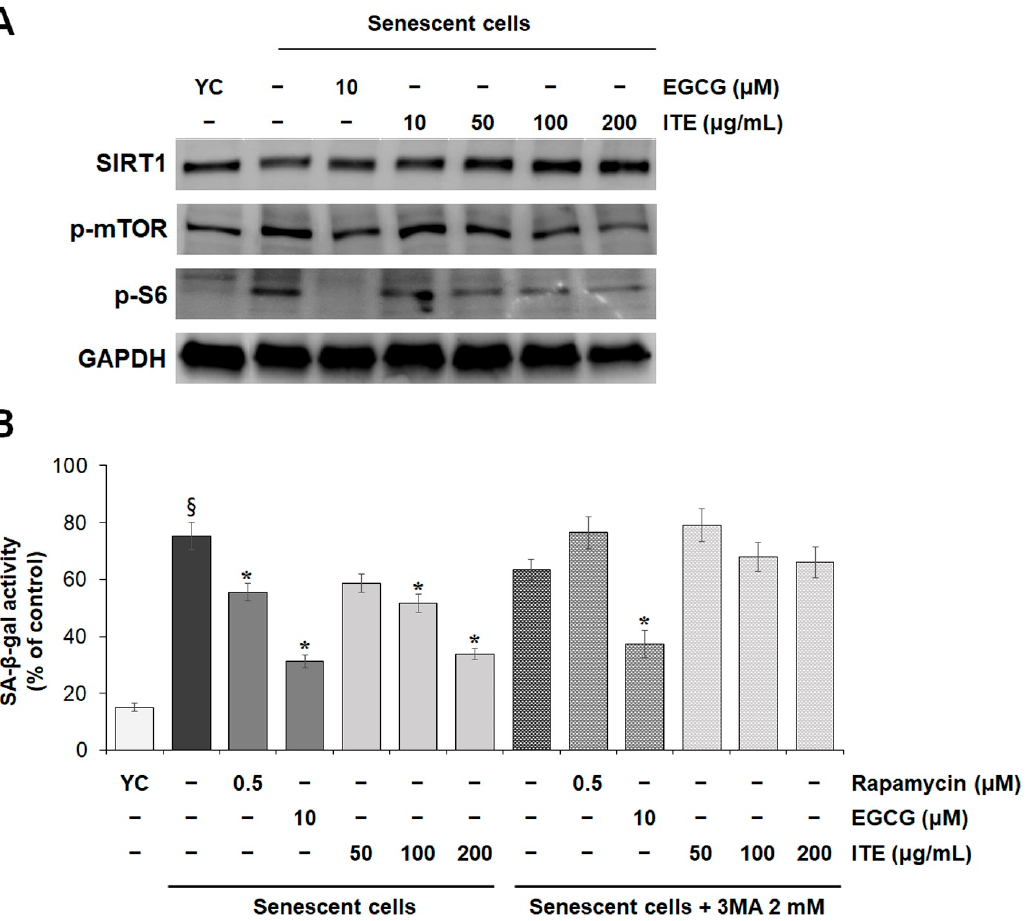
Figure 5. Regulatory effect of ITE on the expression of SIRT1 and mTOR in RS-HDFs. ( A ) Western blot was used to determine the protein expression levels. Each of the figures is representative of 3 independent experiments. GAPDH was used as a control to confirm equal protein loading. ( B ) Effect of simultaneous treatment with ITE and 2 mM 3MA on SA- β -gal activity in RS-HDFs. The data are presented as the mean ± SEM of three independent assays. § p < 0.01 compared to young HDF controls, * p < 0.05 compared to RS-HDF controls. YC, young cell